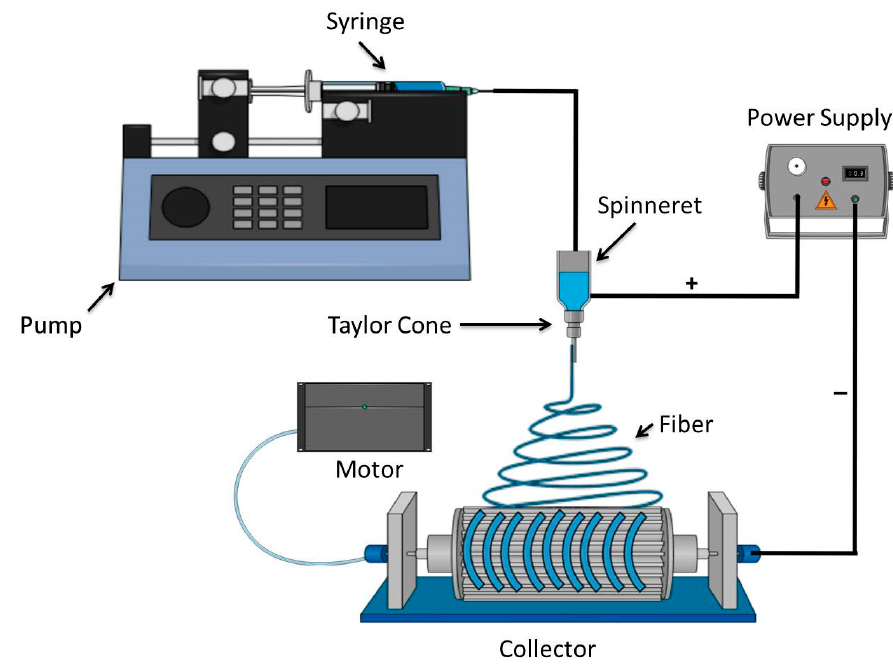
Figure 3. Electrospinning process setups.